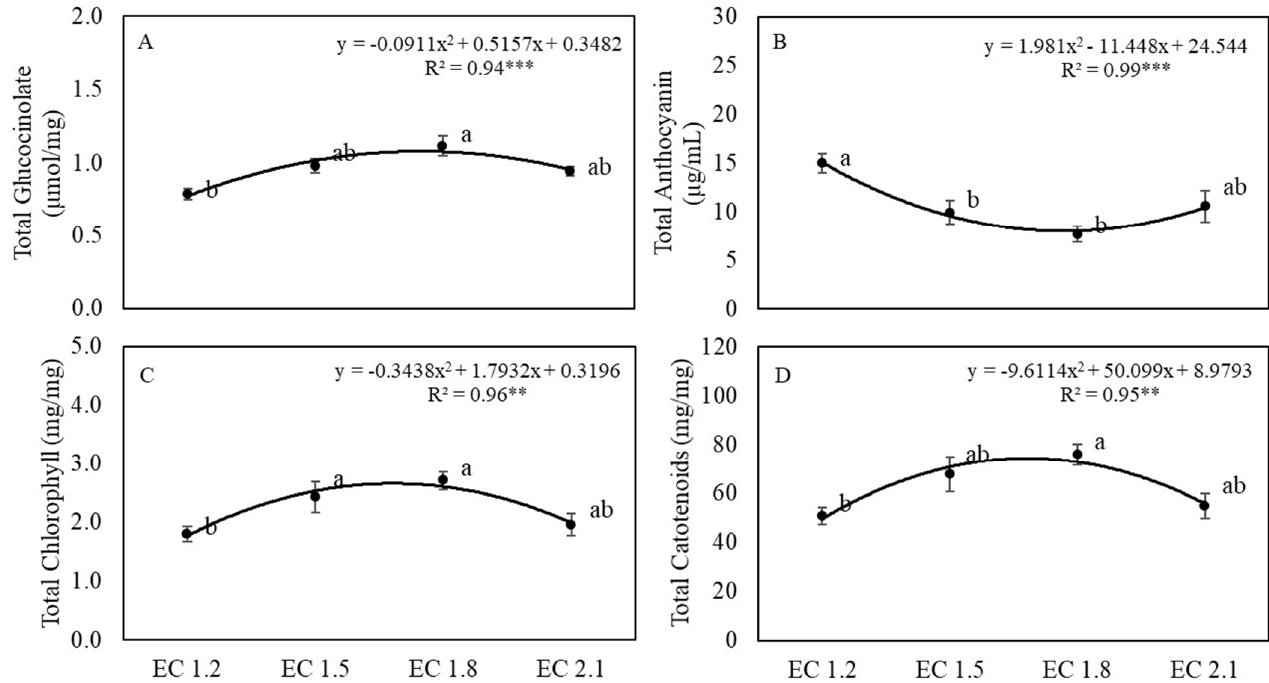
Figure 11. Effect of electrical conductivity (EC) of nutrient solution on the arugula phytochemical content of ( A ) total glucosinolates, ( B ) total anthocyanin, ( C ) total chlorophyll, and ( D ) carotenoids in the shoot part of arugula 4 weeks after transplanting into a nutrient-film technique hydroponic system containing nutrient solutions with EC of 1.2, 1.5, 1.8, or 2.1 dS · m − 1 . Data points with different letters are significantly different according to Tukey’s test ( α = 0.05). Error bars represent the standard errors ( n = 32). ** or *** indicate significance at p of 0.01 or 0.001.